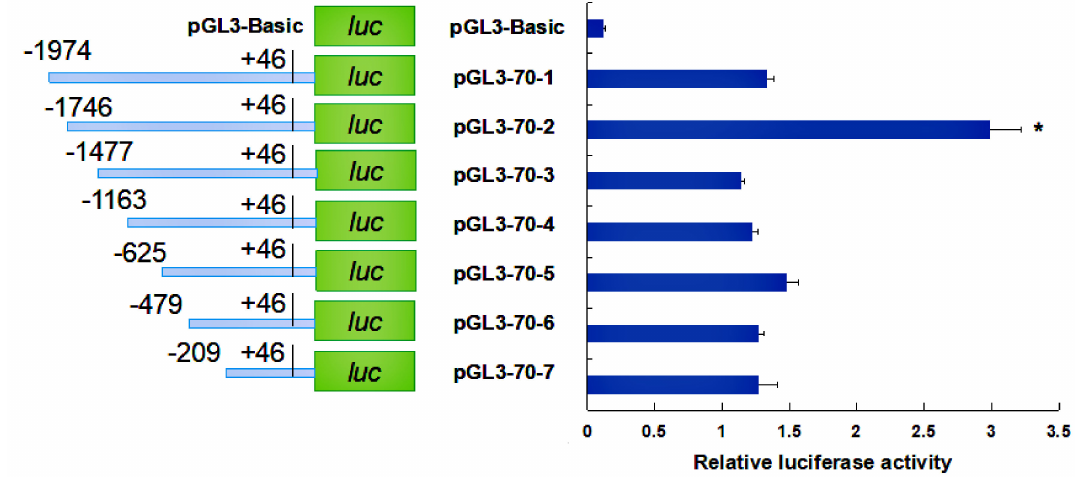
Figure 8. Activity analysis of HdHSP70 gene promoter in HEK293FT cells. Based on the length of the seven fragments, the recombinant plasmids were named pGL3-70-1, pGL3-70-2, pGL3-70-3, pGL3-70-4, pGL3-70-5, pGL3-70-6 and pGL3-70-7. The pRL-TK vector containing Renilla luciferase gene was transfected as an internal reference to correct the transfection efficiency. The pGL3-Basic plasmid was served as a negative control. The significance of luciferase activity differences was analyzed using one-way ANOVA (Analysis of Variance) test. The values were averaged from three independent replicates. Values are means ± SD of biological replicates ( n = 3). The significant difference between pGL3-70-2 and pGL3-70-1 or pGL3-70-3 is indicated by a (*) at p < 0.05. Luc: luciferase expression